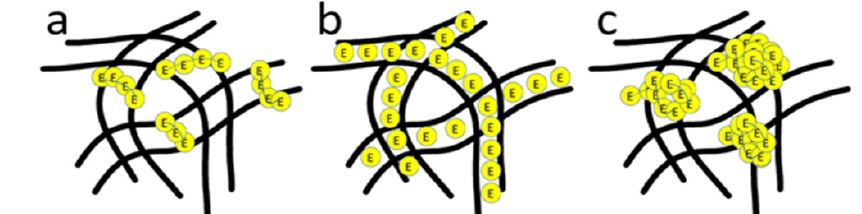
Figure 3. Three types of enzyme immobilization morphology ( a ) strip-shape. ( b ) uniform coating membrane. ( c ) particle aggregates.